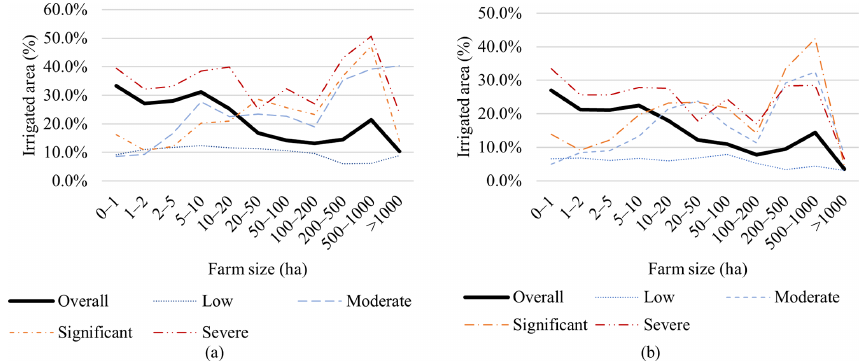
Figure 5. The percentage of irrigated area by farm size according to our farm-size-specific and crop-specific harvested area datasets based on the GAEZv4 crop map (a) and the SPAM2010 crop map (b) under four blue water scarcity levels (WSL) by Mekonnen and Hoekstra (2016). Low blue WSL indicates blue water consumption does not exceed blue water availability, moderate WSL indicates blue water consumption is 100%–150% of blue water availability, significant WSL indicates blue water consumption is 150%–200% of blue water availability and severe WSL indicates blue water consumption is larger than 200% of blue water availability. Table 2. Pearson correlation coefficient between the harvested area of oil palm estimated by satellite images from Descals et al. (2020) and (i) GAEZv4 crop map based farm-size-specific and crop-specific dataset (Gb) and (ii) SPAM2010 crop map based farm-size-specific and crop-specific dataset (Sb), respectively, for small farms ( < 25ha), large farms ( ≥ 25ha), and all farms at various spatial resolutions. All farms compared the oil palm area in GAEZv4 and SPAM2010 crop map, where the results imply the accuracy of our estimates of farm-size-specific and crop-specific harvested area is limited by the accuracy of oil palm locations in crop maps. * p < 0 . 005, ** p < 0 .